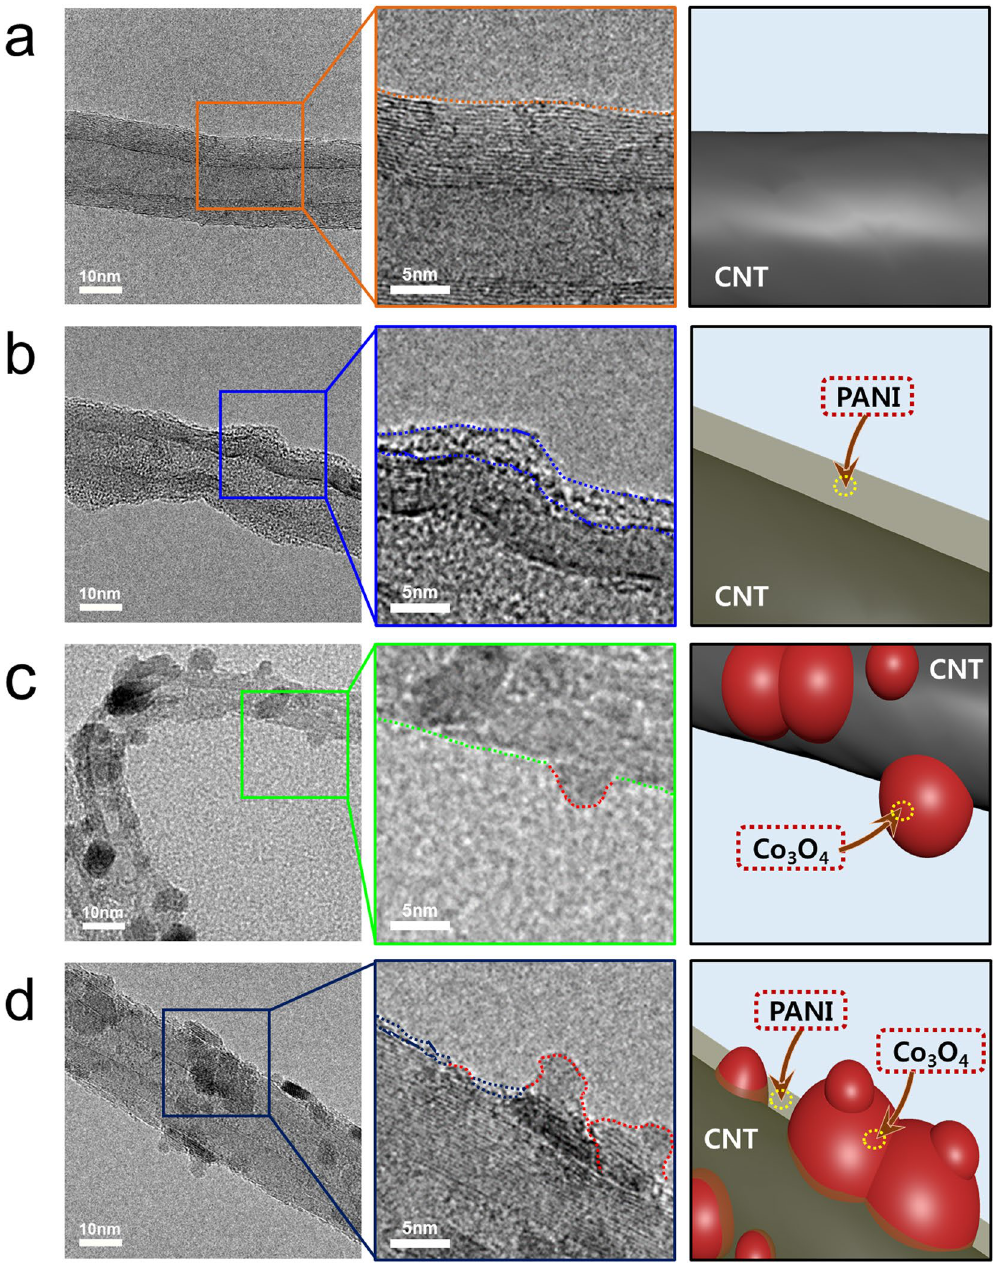
Figure 2. TEM images of ( a ) the pristine CNTs, ( b ) the PANI-coated CNT, ( c ) the CNT/Co 3 O 4 nanocomposite, and ( d ) the selectively PANI-coated CNT/Co 3 O 4